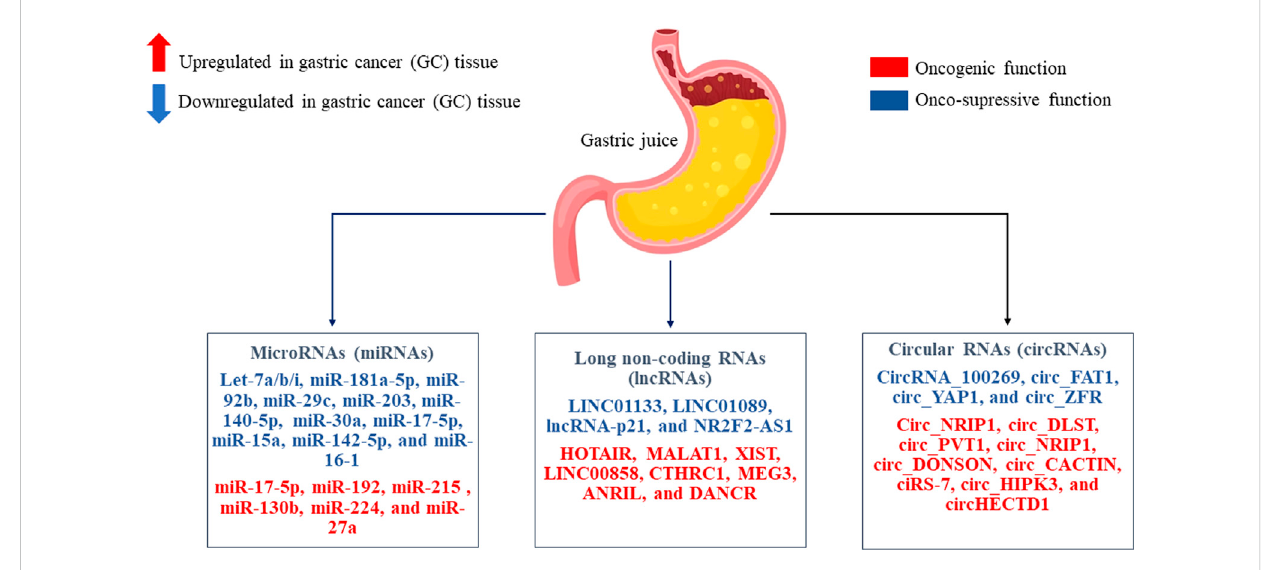
FIGURE 3 Themoststudied/studiedmicroRNAs(miRNAs),longnon-codingRNAs(lncRNAs),andcircularRNAs(circRNAs)intheoncogenesisofgastriccancer (GC) tissue are presented. These non-coding RNAs (ncRNAs) that play a role as onco-suppressors or oncogenic role. Perhaps it will be possible to consider them as non-invasive biomarkers based on gastric juice in GC with further